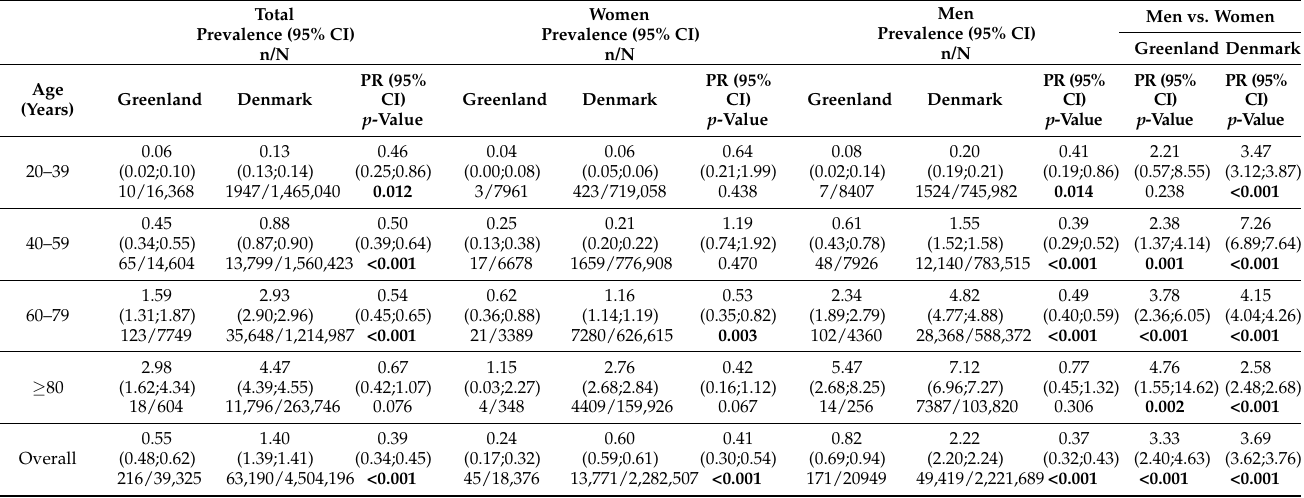
Men vs. Women Greenland